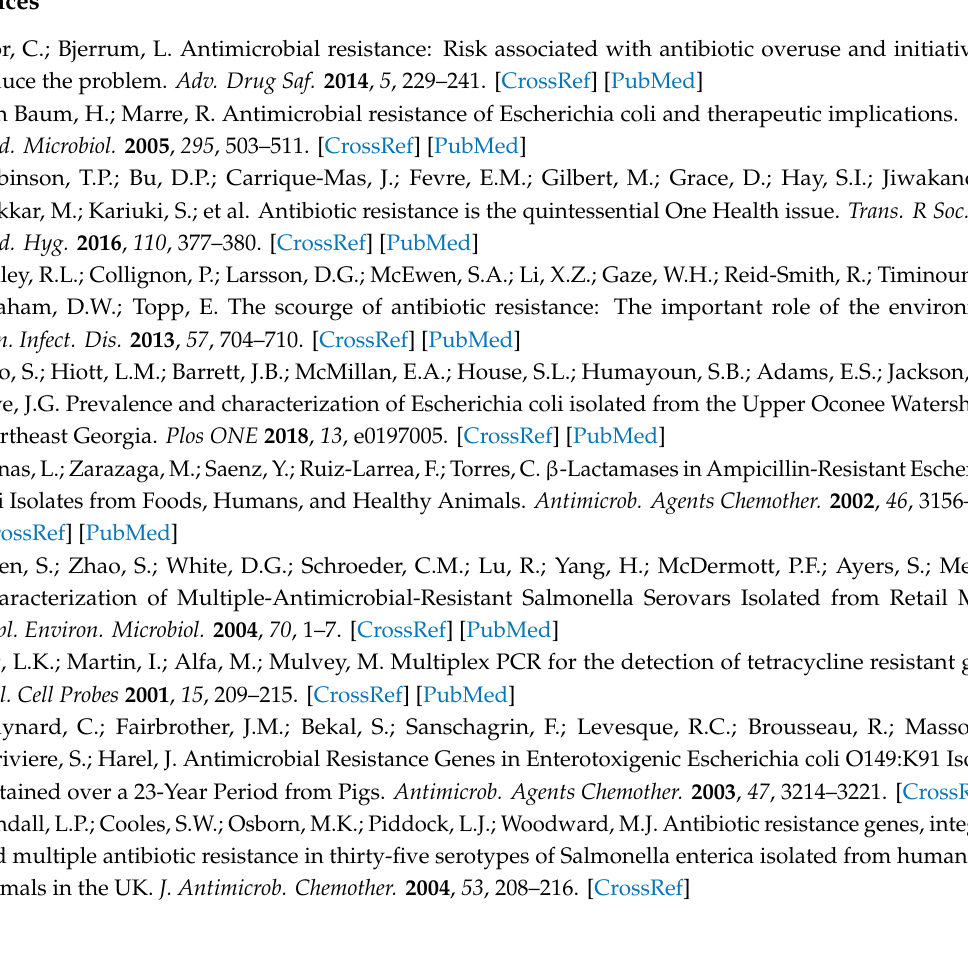
Table S1: Master file of the 34 antimicrobial resistant E. coli isolates from surface